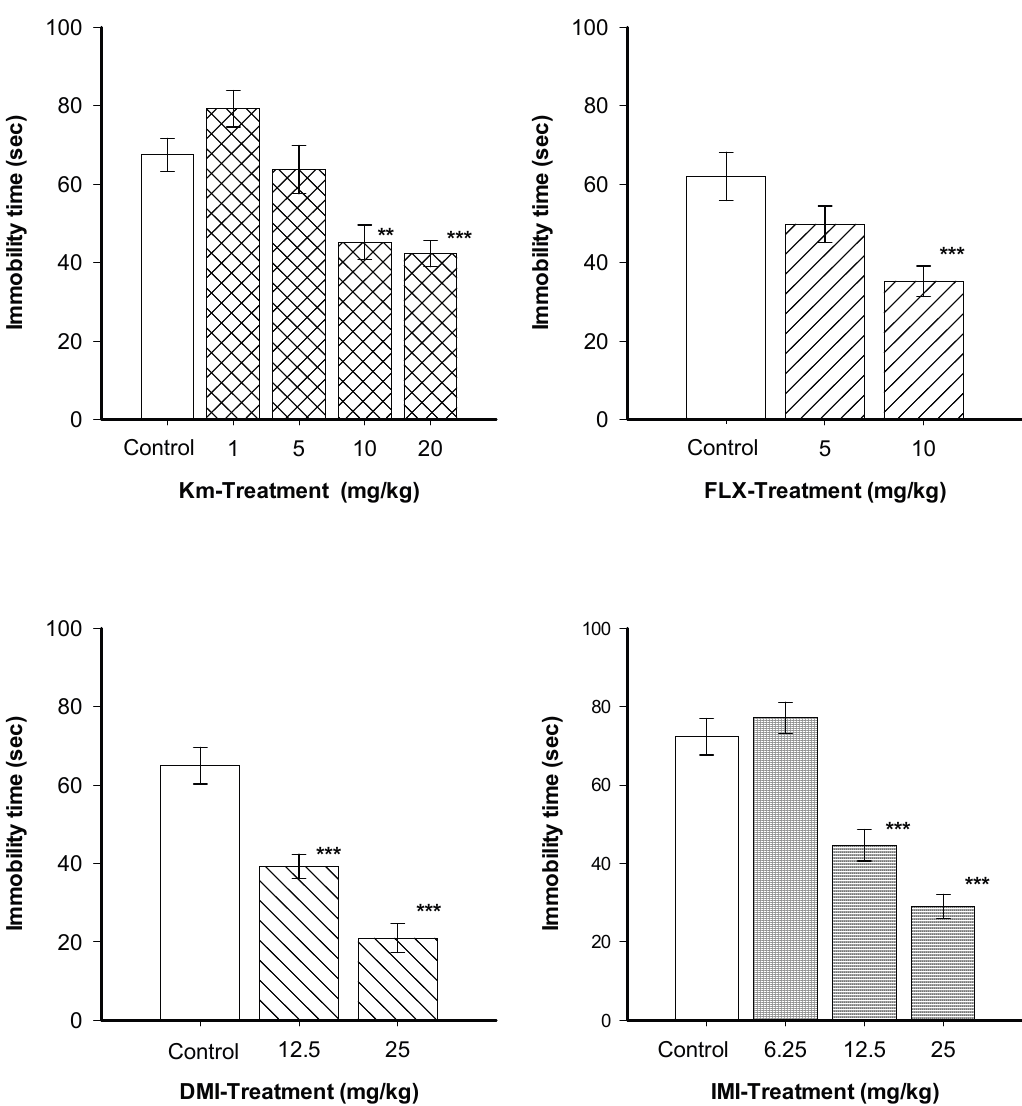
Figure 2. Effects kaempferitrin (Km), fluoxetine (FLX) desipramine (DMI), and imipramine (IMI) on the tail suspension